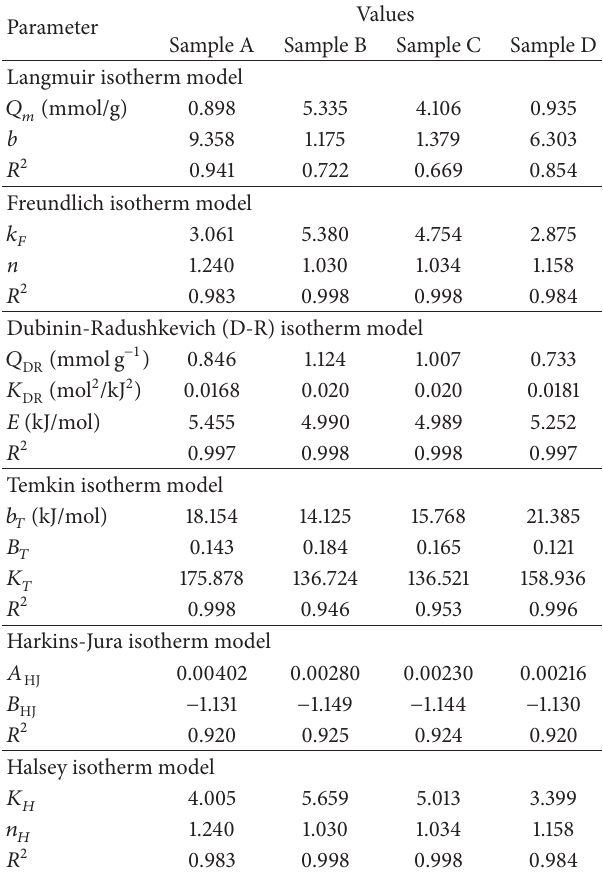
Table 1: The Langmuir, Freundlich, Dubinin-Radushkevich (D-R), Temkin, Harkins-Jura, and Halsey isotherm parameters for lead(II)